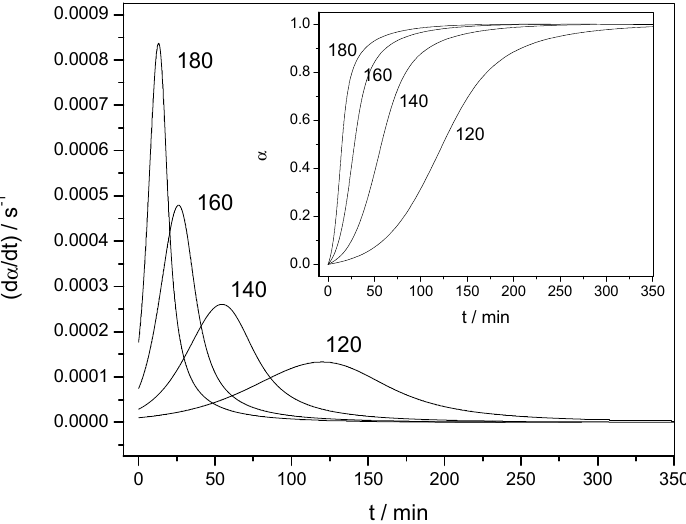
Figure 3. Isothermal data. Variation of the reaction rate (d α /d t ) with time ( t ) for data set 1. Inset: Variation of the extent of conversion ( α ) with time ( t ). The temperature of each experiment (in °C) is indicated by each curve.